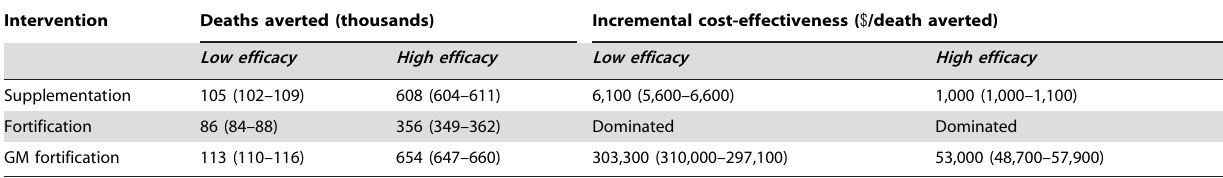
Table 5. Deaths averted for each intervention over 20-year time